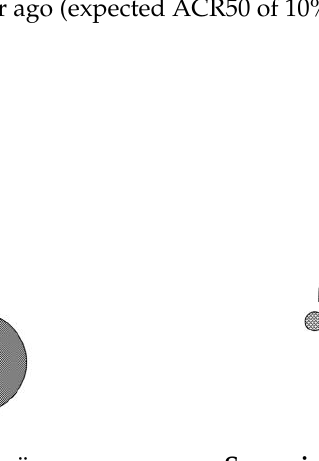
Figure 3. Impact of placebo effect on study size calculations. If phase I/II studies conducted in rheumatoid arthritis suggest a response rate of 70% for a new active drug, there are two feasible scenarios for study size calculations for phase III clinical trials. In scenario 1, all included patients are DMARD-naïve (100%) and the expected ACR50 response, due to the large placebo effect, is 60%. Here, the calculated number ( n ) of study participants is in total 992, with 496 for each of the two study arms. In scenario 2, all patients are pre-treated with DMARDs (0% DMARD naïve) and thus an ACR50 response score of 10% can be anticipated. Here, only 32 study participants, with 16 per arm, are required. Calculations were performed with the SAS system, using the POWER procedure Fisher’s exact conditional test for two proportions, with alpha of 0.05 and a nominal statistical power of 0.9.